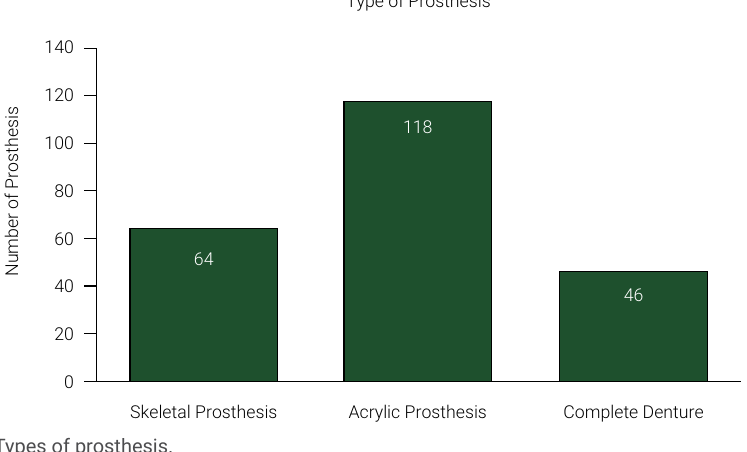
Figure 1. Types of